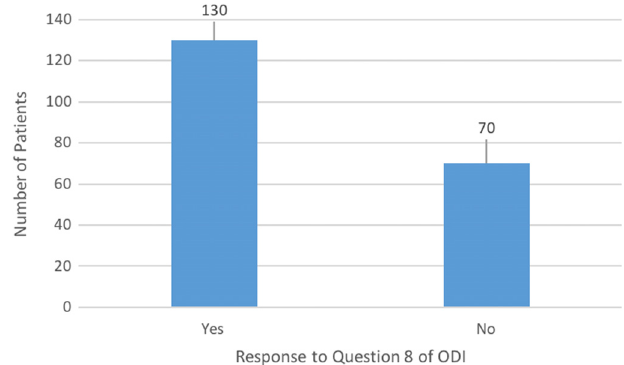
Figure 6. Graphical representation of the response to question 8 of the